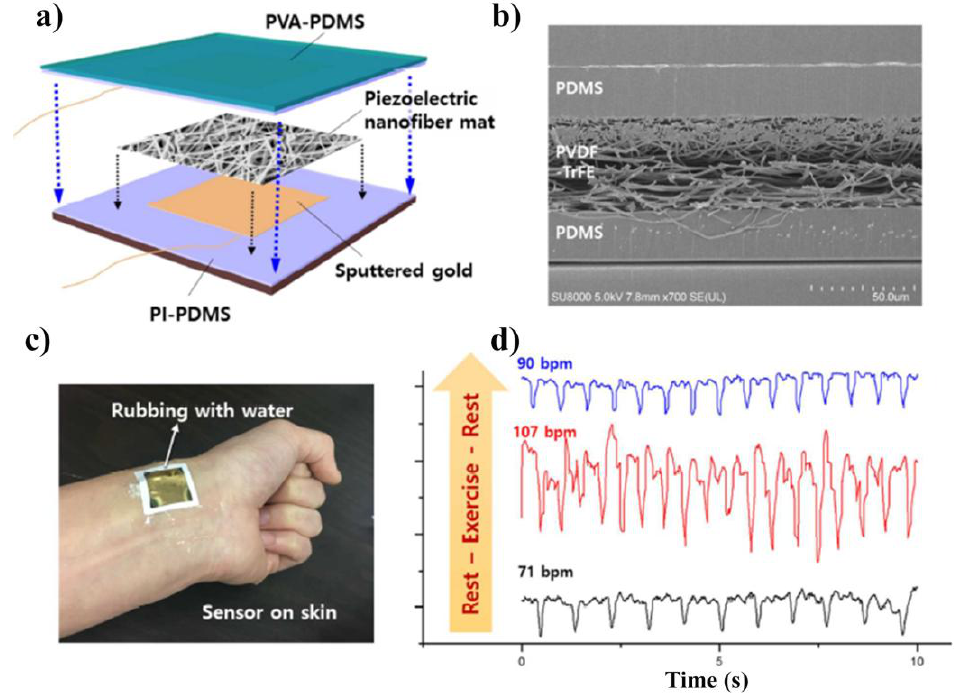
Figure 2. ( a ) Schematic illustration of a flexible piezoelectric sensor configuration including a P(VDF-TrFE) nanofibre mat sandwiched between a layer of PDMS and PVA-PDMS; ( b ) SEM image of the cross-section of the integrated sensor; ( c ) photographs of the integrated sensor applied on skin and ( d ) real-time sensor output waveforms at three consecutive body conditions before and after exercise. Reproduced with permission [196].